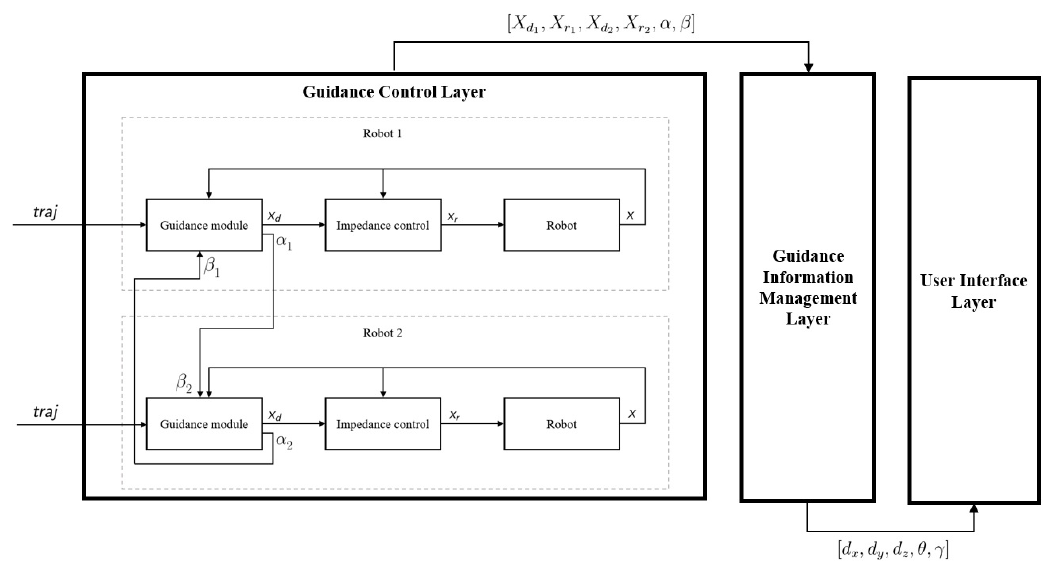
Figure 1. Architecture for dual arm